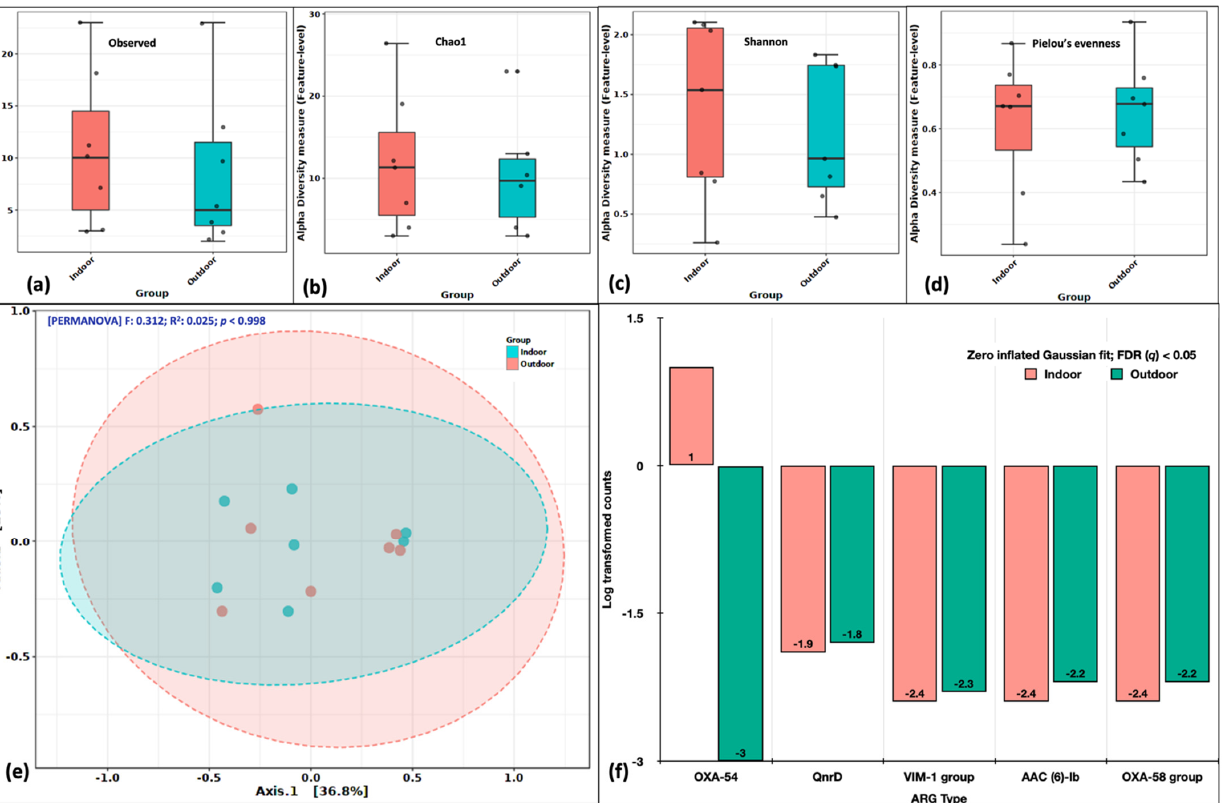
Figure 4. Variations in ARG abundance between indoor and outdoor aerosols. Alpha diversity analysis: ( a ) Observed features, ( b ) Chao1 indices, ( c ) Shannon’s evenness and richness, ( d ) Pielou’s evenness index. Beta diversity analysis: ( e ) Principal coordinate analysis (PCoA) on Bray Curtis distances through Ward algorithm. Di ff erential abundance testing: ( f ) fi tZig model (DESeq2). The green colour in each fi gure represents the indoor samples, whereas the red colour represents outdoor aerosols.